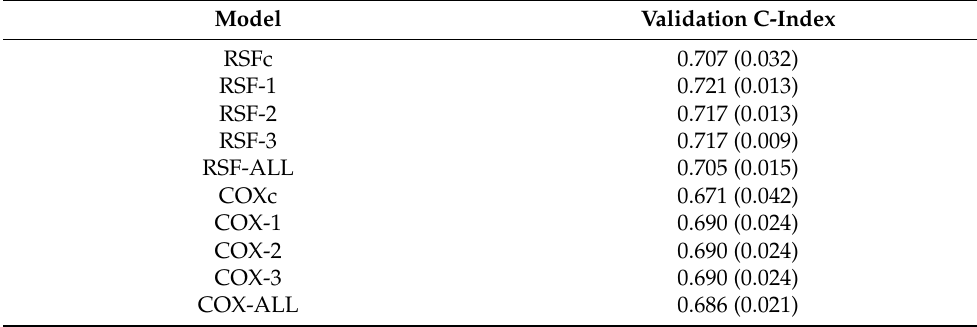
Figure 1. The host factors are mutually correlated. ( A ) The heatmap of the absolute Spearman correlation ( | ρ s | ) between host factors and the hierarchical clustering based on correlations. The correlations were obtained using the training cohort data. ( B ) The heatmap of the Spearman correlation ( ρ s ) between host factors in the first cluster. ( C ) The biplot of the PCA of the host factors. The biplot shows the projections (contributions) of each host factor to the first two principal components. A large horizontal (vertical) projection suggests the host factor primarily contributes to the PC1 (PC2). Two host factors with projections to the same (opposite) direction suggest they are positively (negatively) correlated with projections onto other PCs ignored. Perpendicular projections imply independence, for example RBC and WBC. The variance explained by each component are shown in corresponding axis labels. Table 3. Model performance evaluated by the average C-index from